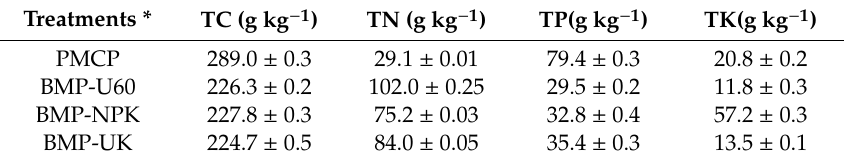
Figure 1. Diagram of processing the supplemented biochar manure pellets with different types of fertilizer. Table 2. Total carbon, total nitrogen, total phosphorus and total potassium contents of supplemented biochar manure pellet fertilizers 1) .